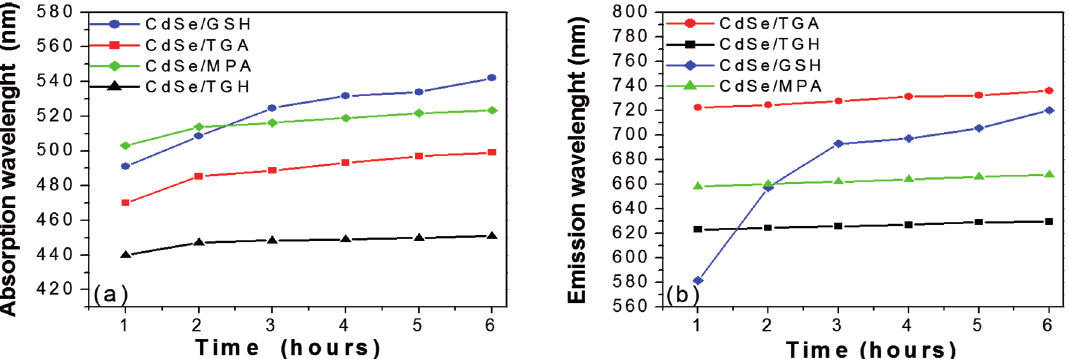
Figure 6: Temporal evolution of the maximum (a) absorption and (b) emission peaks of CdSe QDs with MPA, GSH, TGA, and TGH surface ligands.